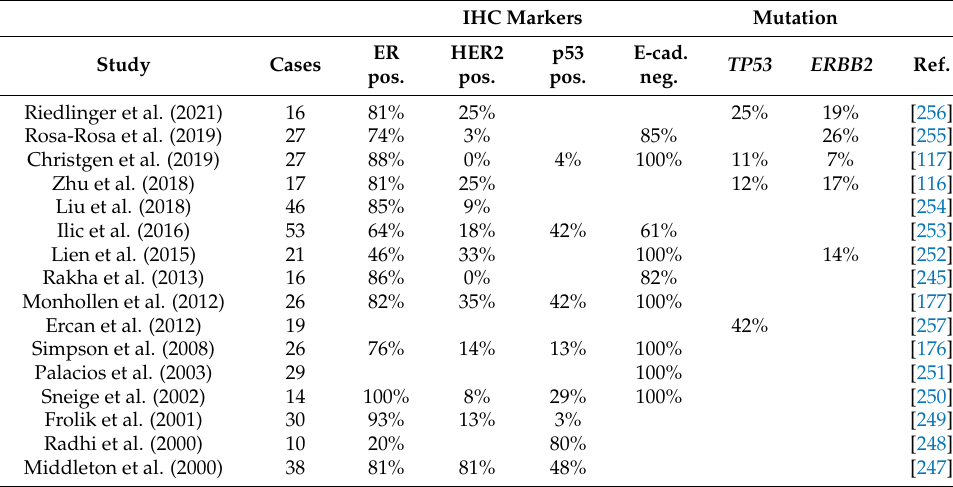
Table A6. Features of pleomorphic